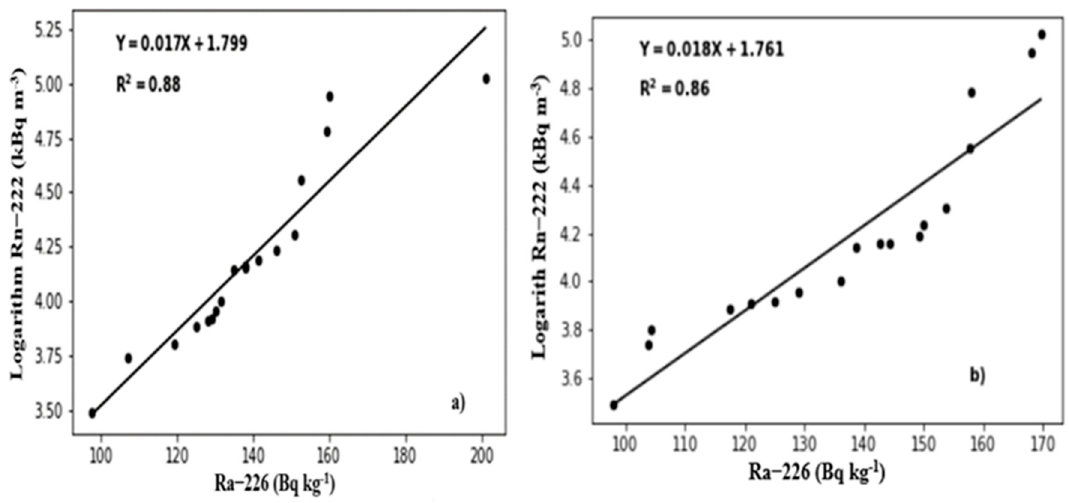
Figure 4. Correlation between 222 Rn/ 226 Ra concentrations in soil: ( a ) laboratory gamma-ray spec- trometry and ( b ) in situ gamma-ray spectrometry.